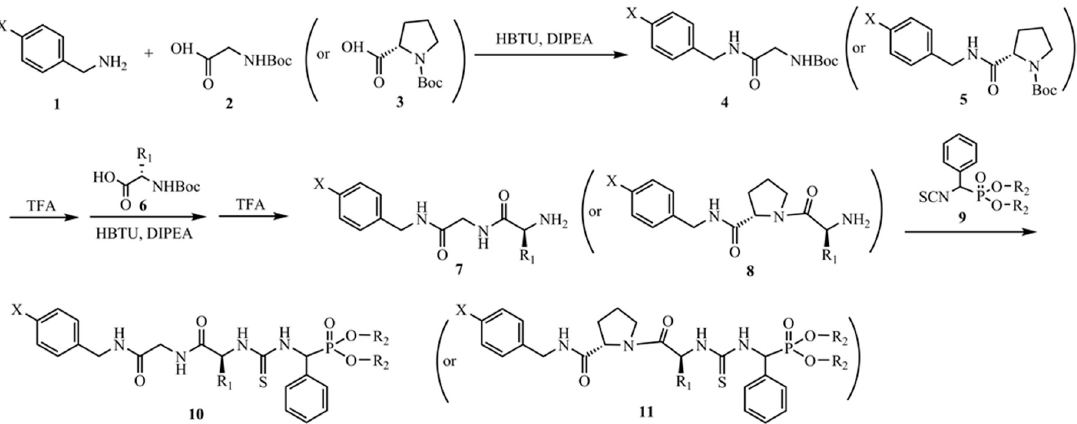
Figure 1. Synthetic route for novel thioureas 10 and 11 .